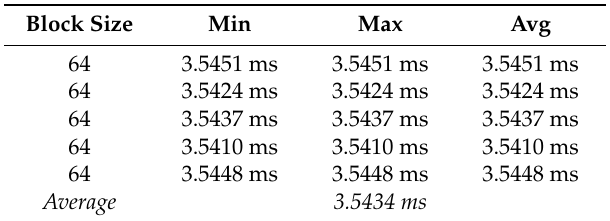
Table 8. Running the nvprof profiler with a block size of